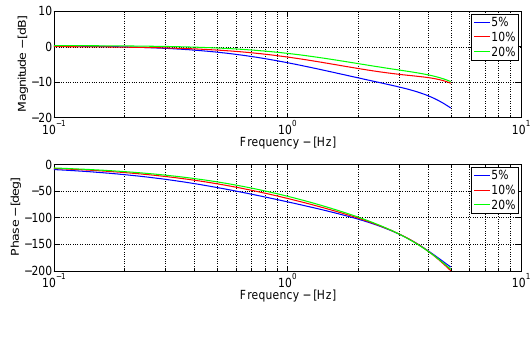
Figure 12: Results at 50% positive offset. The fitted transfer functions shown in Figure 12 rep- resents the experimental test data given by Figure 7. The coefficients describing Equation 7 which are found using the system identification method are given in Ta- ble 1. Table 1: Positive offset coefficients.